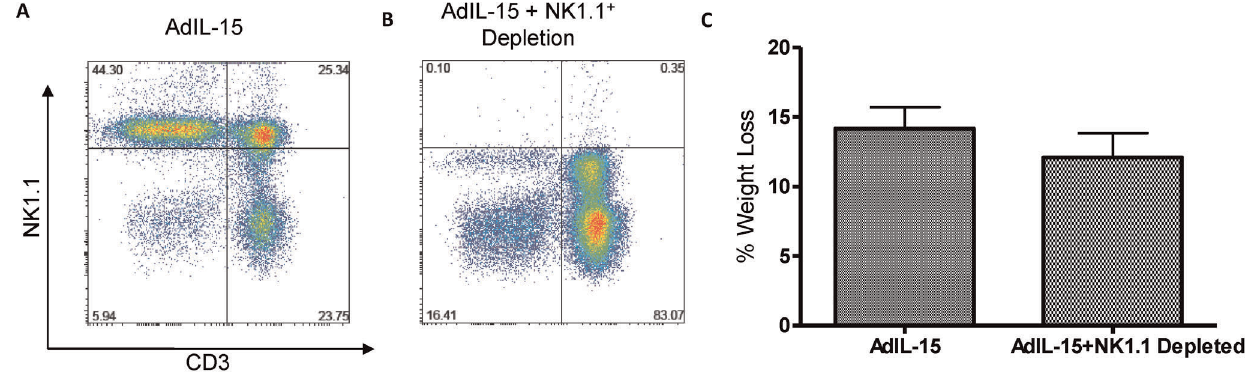
Figure 3. Treatment with interleukin-15 induces weight loss in NK1.1 + cell depleted B6 mice. Analysis of CD3 and NK1.1 cells gated from a CD45.2 + population in ( A ) AdIL-15 treated B6 mice and ( B ) NK1.1 + depleted AdIL-15 treated mice in visceral gonadal adipose tissue. ( C ) Bar graph shows weight loss in female treated mice (n=7 per group).